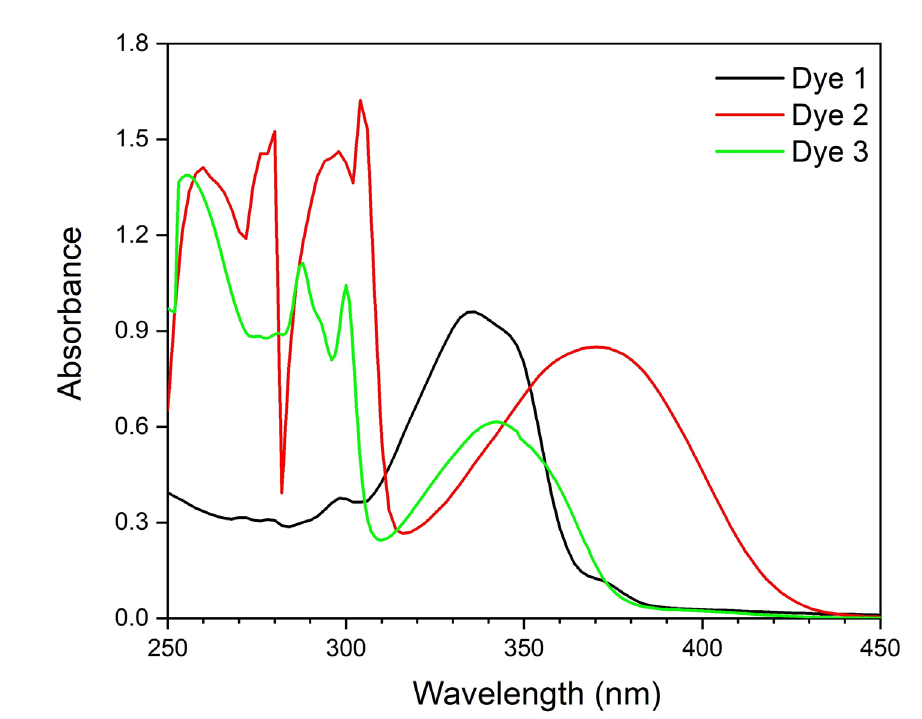
FIGURE 2 - Absorption spectra of benzoxazole dyes 1-3 in ethanol (c= 10 -4